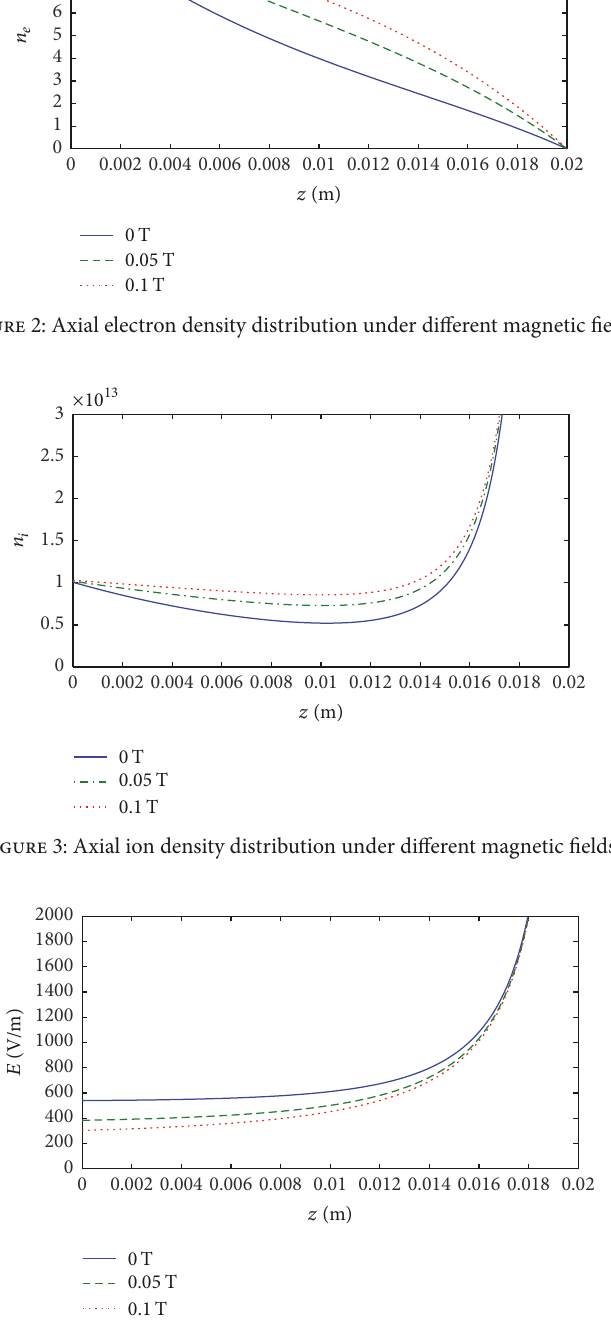
Figure 4: Electric field distribution under different magnetic